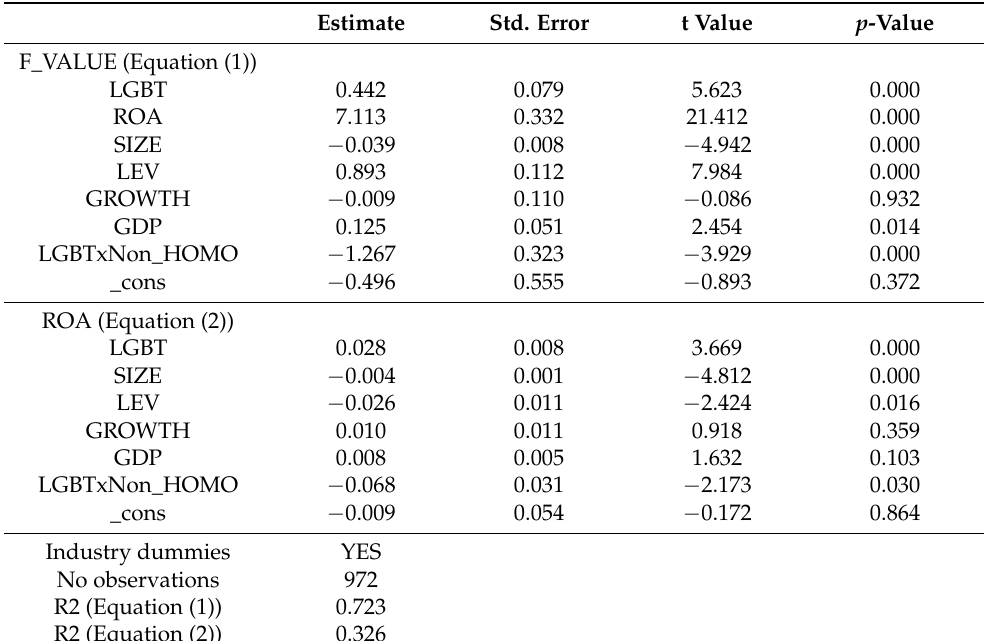
Table 6. Results of the simultaneous estimation (additional